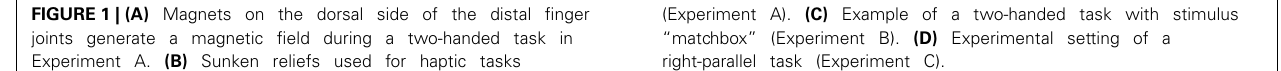
FIGURE 1 | (A) Magnets on the dorsal side of the distal finger joints generate a magnetic field during a two-handed task in Experiment A. (B) Sunken reliefs used for haptic tasks